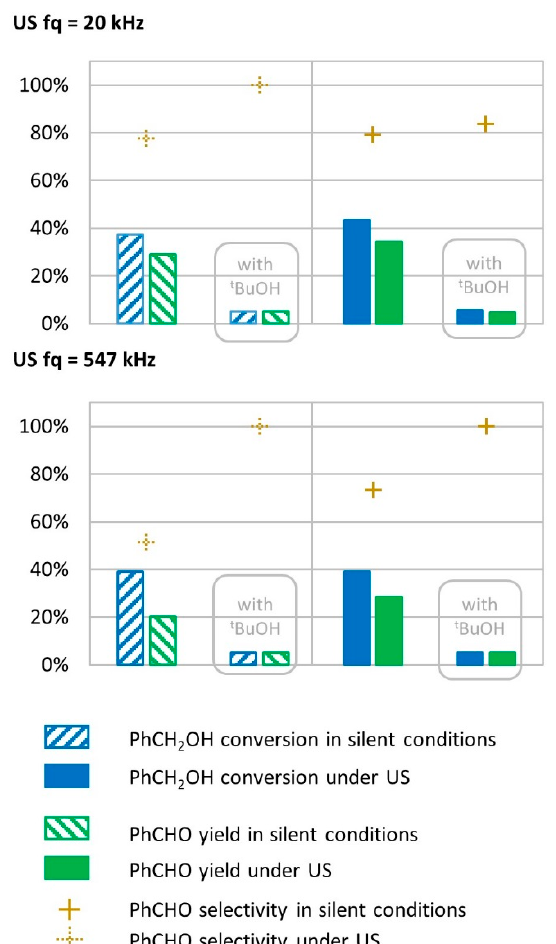
Figure 8. Oxidation of PhCH 2 OH with tert- butanol as radical inhibitor in silent condition and under US irradiation (20 kHz and 547 kHz). Reaction conditions under 20 kHz and silent conditions; 571 mM PhCH 2 OH, 1 molar equivalent of H 2 O 2 , 1% molar equivalent of catalyst, 5.61 mL H 2 O, 70 ◦ C, 15 min. Silent conditions: Argon bubbling; US conditions: 20 kHz, P acous = 47.9 W L − 1 h − 1 , 13 mm probe; under 547 kHz and in silent conditions: 571 mM PhCH 2 OH, 1 molar eq. H 2 O 2 ; 1% molar eq. FeSO 4 , 56.1 mL H 2 O, 70 ◦ C. Silent conditions: Argon bubbling; US conditions: 547 kHz, P acous = 55.5 W L − 1 h − 1